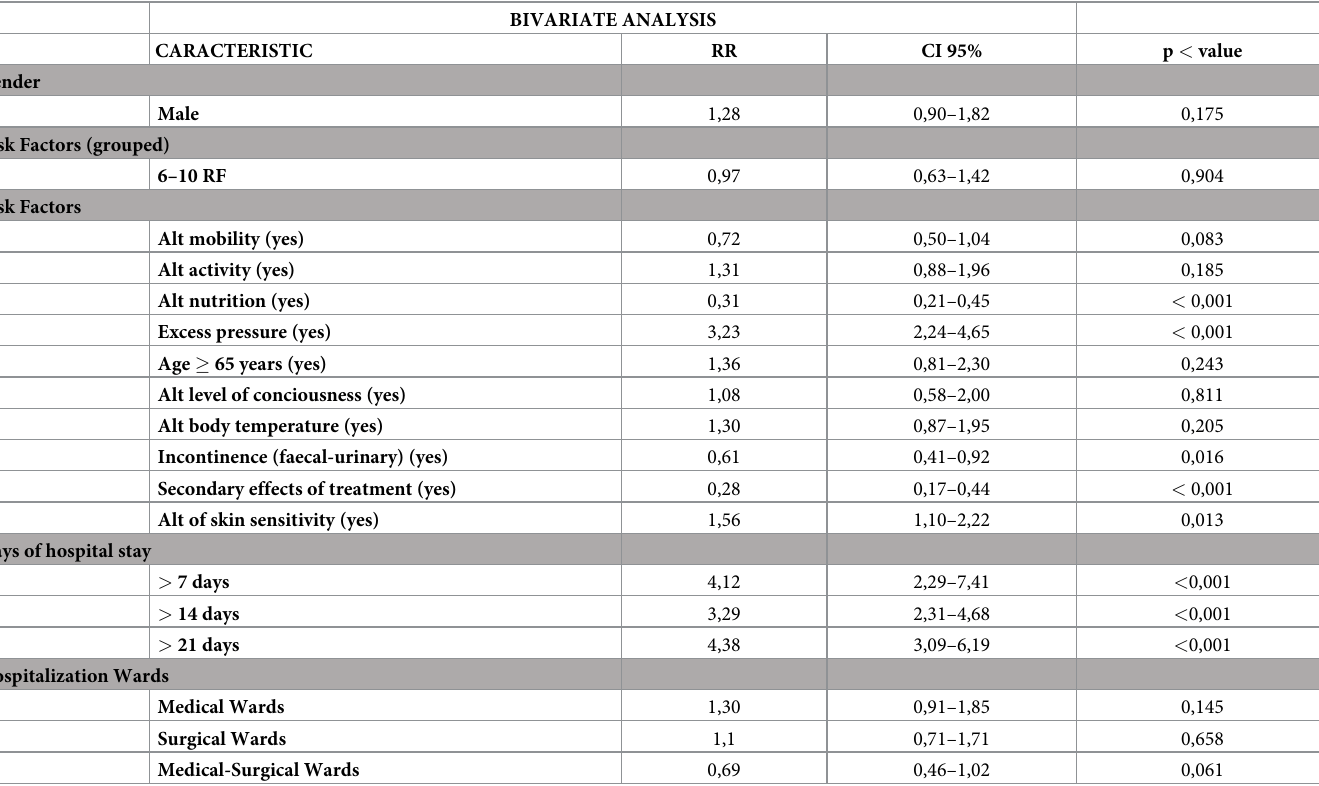
Table 5. Shows a bivariate analysis. Risk factors associated with the presence of HAPU in patients with “minimal risk” assessment on the Norton-MI